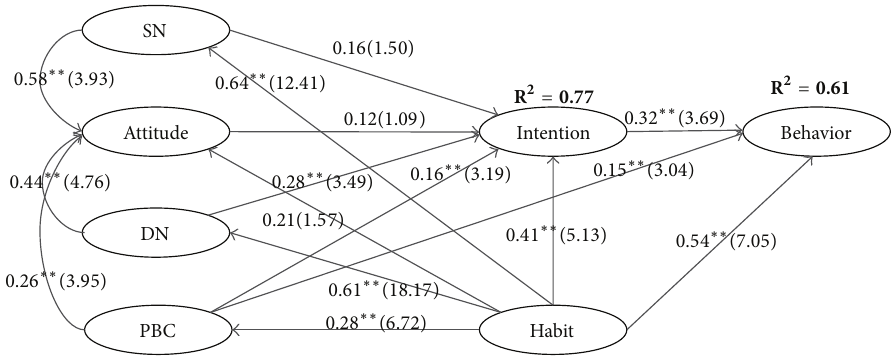
Figure 9: Standardized coefficients between the latent factors using coach.